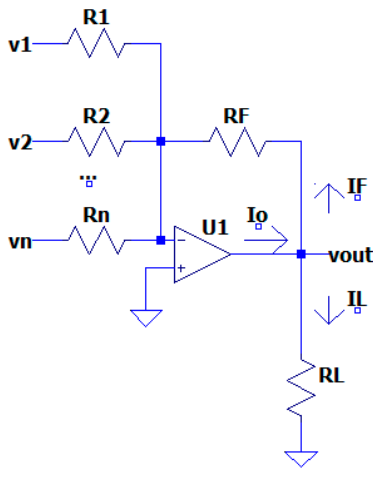
Figure 2. Inverting summing amplifier [44].